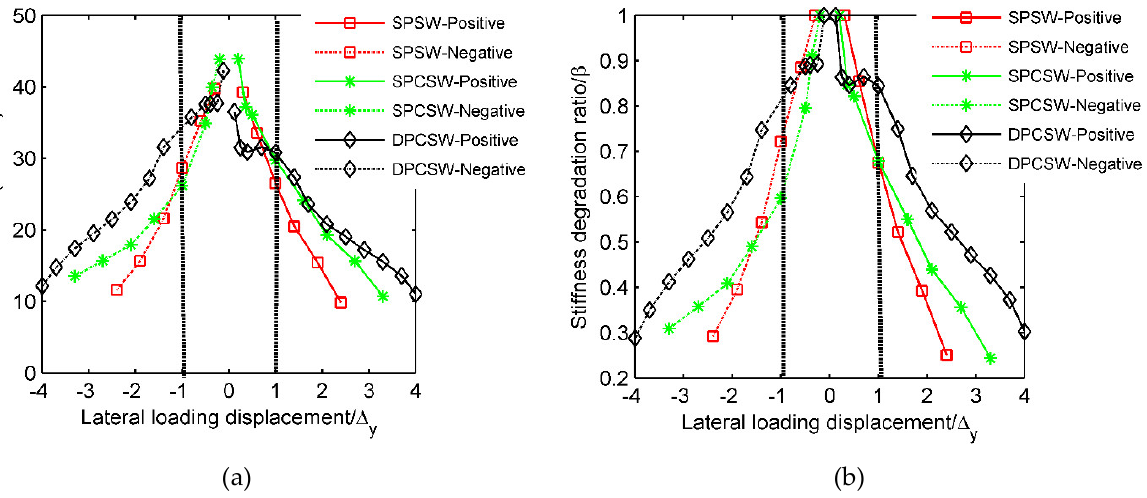
Figure 14. Stiffness degradation of three specimens: ( a ) changes of stiffness; ( b ) changes of stiffness degradation ratio.